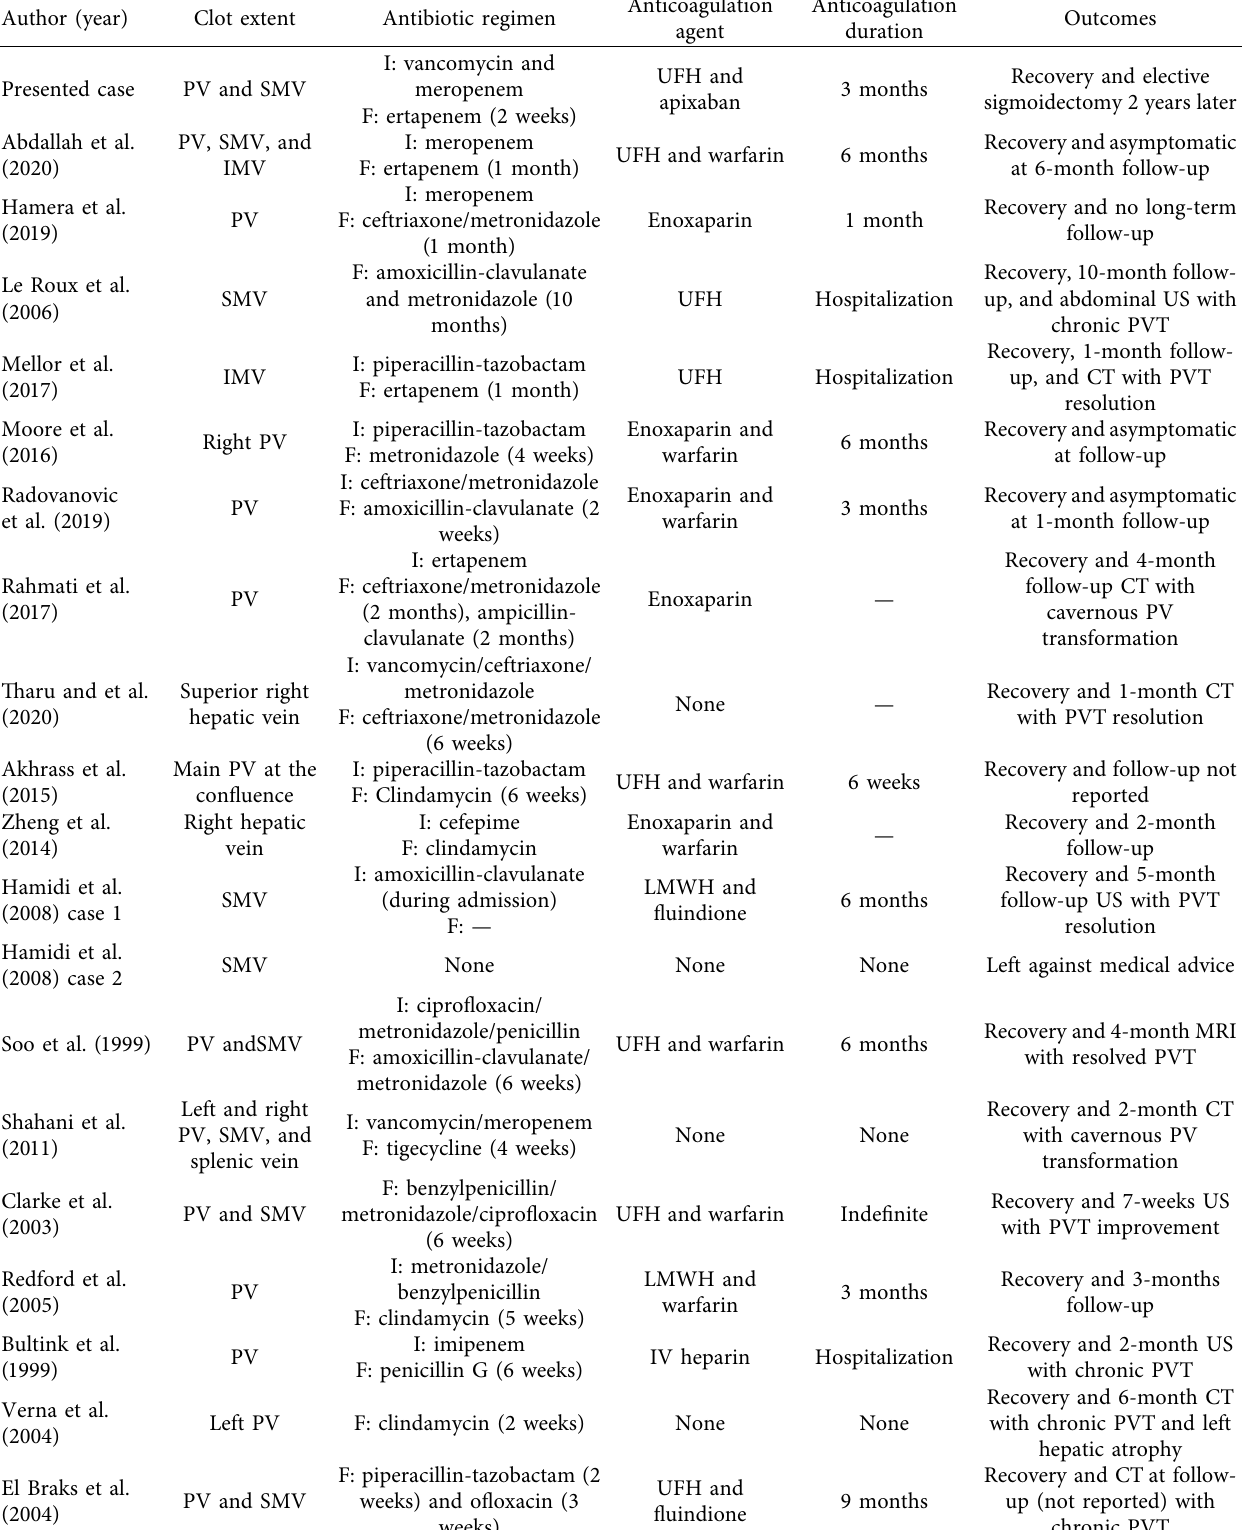
Table 2: Thrombus extent, management, and outcomes in patients with Fusobacterium-spp. -associated pylephlebitis. Author